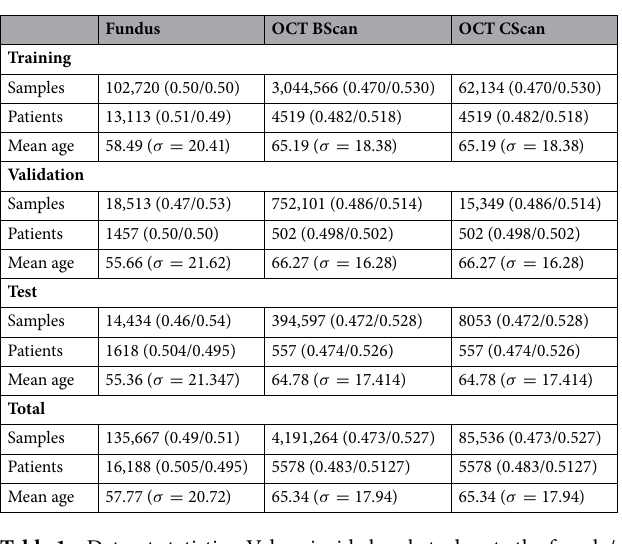
Table 1. Dataset statistics. Values inside brackets denote the female/male ratio of the set.